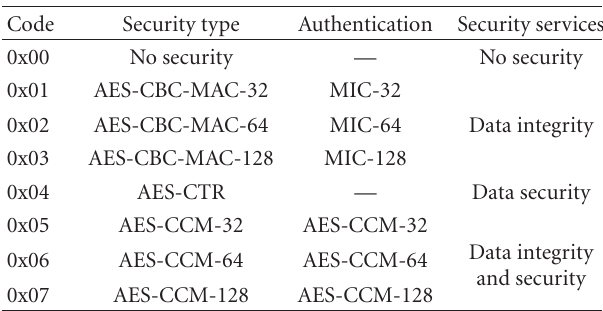
Figure 15: IEEE 802.15.4 and ZigBee role in the ISO/OSI stack. Table 5: Security control codes.